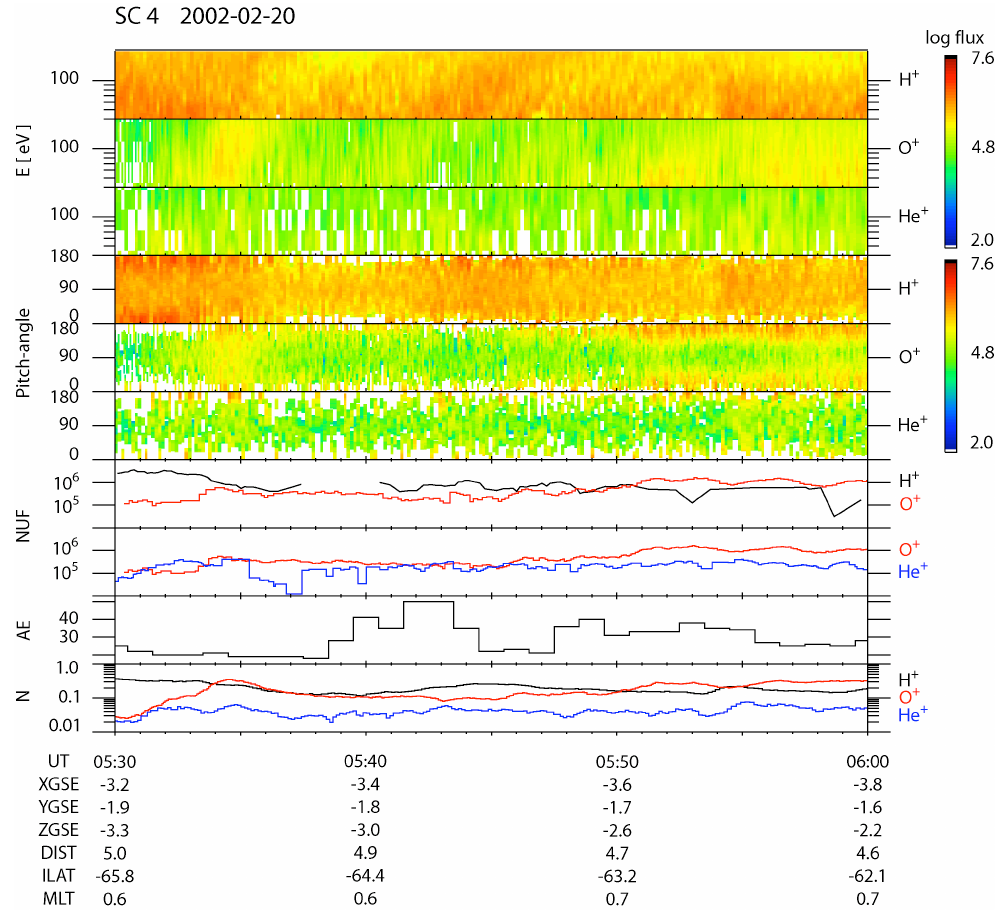
Figure 6: Energy-time spectrograms and differential fluxes in [(cm 2 s sr) -1 ], pitch-angle Fig. 6. Energy-time spectrograms, pitch-angle distributions [(cm 2 ssrkeV) − 1 ], net upgoing fluxes (NUF) in [cm − 2 s − 1 ], AE in [nT] and density plot in [cm − 3 ] in the low energy range of 40eV to 200eV for H + , O + and He + during the period from 05:30UT through 06:00UT, on 20 February distributions, net upgoing fluxes (NUF) in [cm -2 s -1 ], AE in [nT] and density plot in [cm -3 ] in the low energy range of 40 eV to 200 eV for H + , O + and He + during the period from 05:30 UT through 06:00 UT, on February 20, 2002.